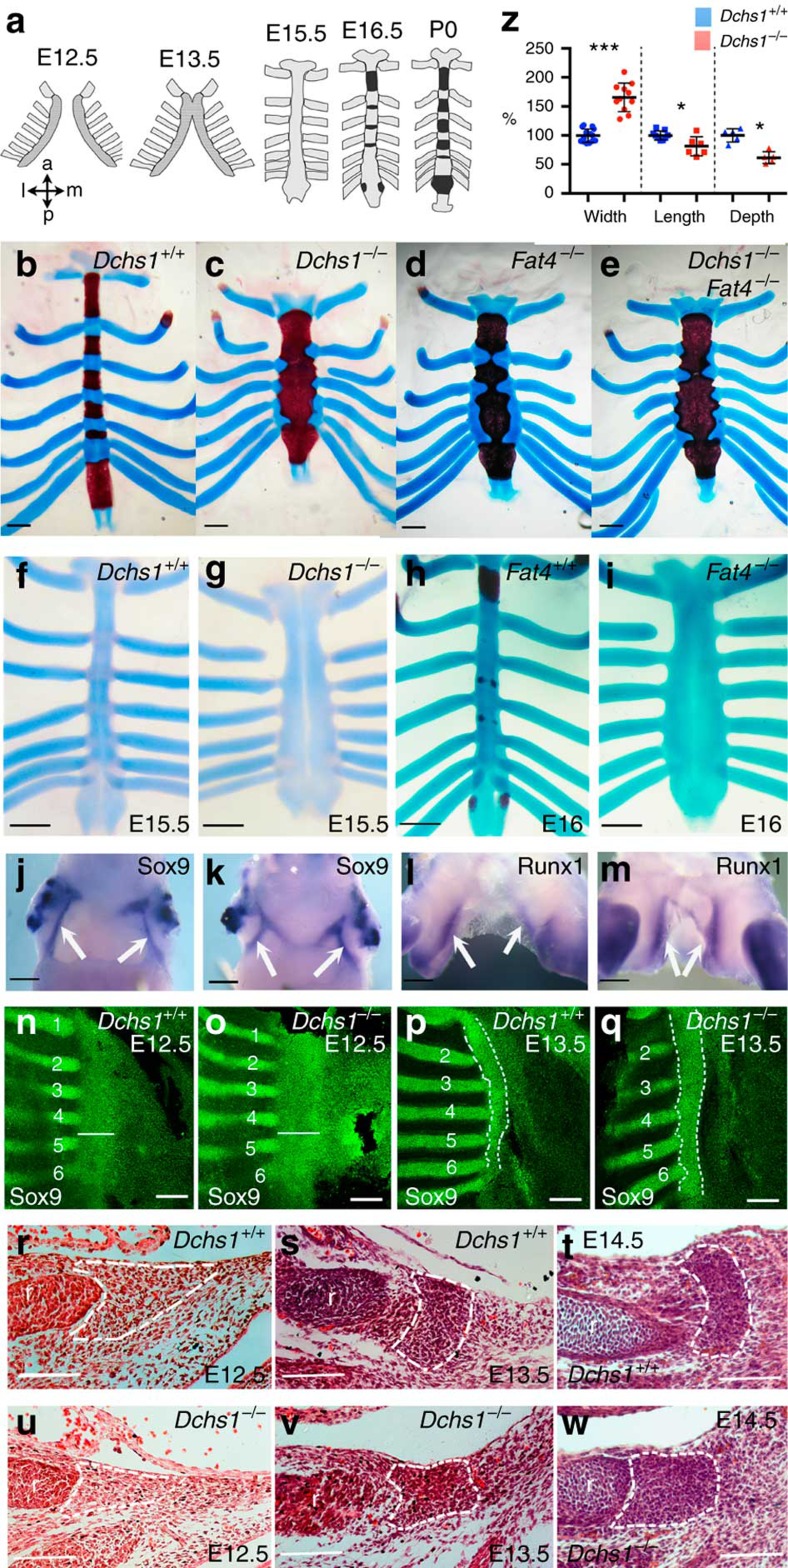
Sternum development in Fat4 and Dchs1 mouse mutants.(a) Diagram illustrating mouse sternum development between E12.5 and P0; the darker areas at E12.5 and E13.5 show the pre-cartilaginous condensations and the black regions at E16.5 and P0 indicate ossification of the intercostal regions. (b–i) Alcian blue and alizarin staining of P0 (b–e), E15.5 (f,g), E16.0 (h,i) sterna and ribs in wild-type (b,f,h), Dchs1−/− (c,g), Fat4−/− (d,i) and Dchs1−/−Fat4−/− (e) mutants; cartilage is stained blue, bone is red. (j–m) Ventral views of E12.5 wild type (j,l), Dchs1−/− (k) and Fat4−/− (m) sterna showing in situ hybridizations of Sox9 (j,k) and Runx1 (l,m) expression; the sternal plates are arrowed. (n–q) Flatmounts of E12.5 (n,o) and E13.5 (p,q), wild type (n,p) and Dchs1−/− (o,q) sterna that have been immunostained for Sox9 (green), which is expressed in the sternal plate and ribs: the width of the sternal plate is indicated by the white bar in (n,o) and the sternum is outlined in (p,q); the ribs are numbered. (r–w) Haematoxylin and eosin stained sections through the dorso-ventral axis of the developing sternum at E12.5 (r,u), E13.5 (s,v) and E14.5 (t,w) in wild-type (r–t) and Dchs1−/− (u–w) embryos; the sternum is outlined by the white dashes. r, rib. (z) Bar chart showing % change in width, length and depth in E14.5 Dchs1−/− sterna compared with average sterna measurement in wild-type embryos that was standardized to 100%. The lines indicate mean (thicker black bar), 25 and 75%. Student's t-test: *P<0.05, ***P<0.001. Scale bars, 1 mM (b–e,j–m); 500 μM (f–i); 200 μM (n–q); 100 μM (r–w).